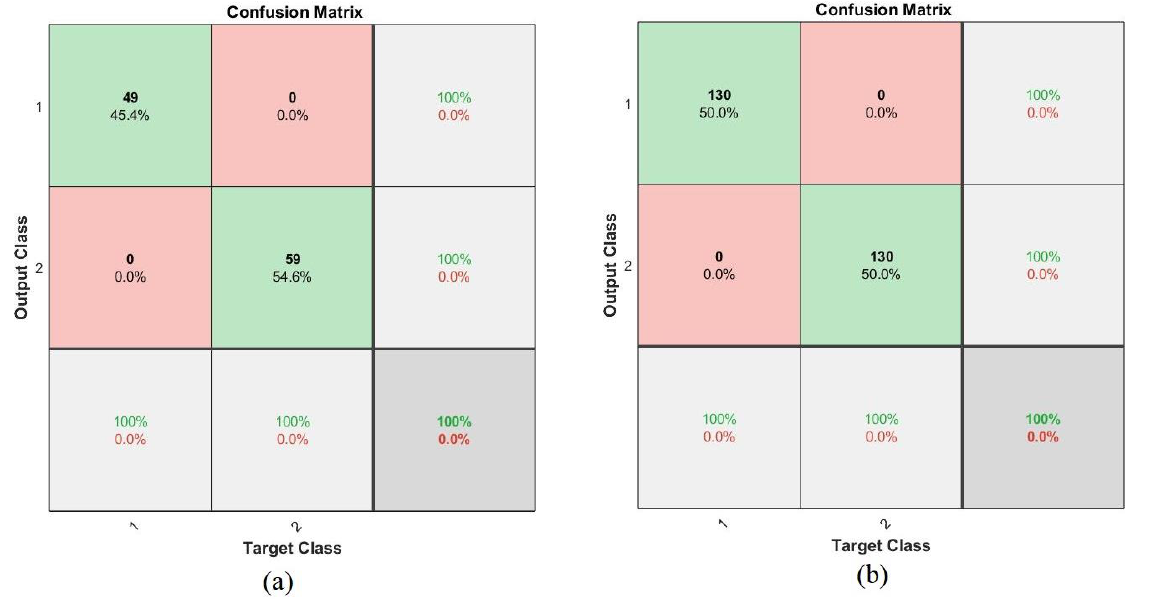
Figure 19. Confusion matrix for the FFNN algorithm of the ( a ) ALL_IDB1 and ( b ) ALL_IDB2 datasets. Table 2. The performance of the ANN and FFNN algorithms on the ALL_IDB1 and ALL_IDB2 da- tasets.